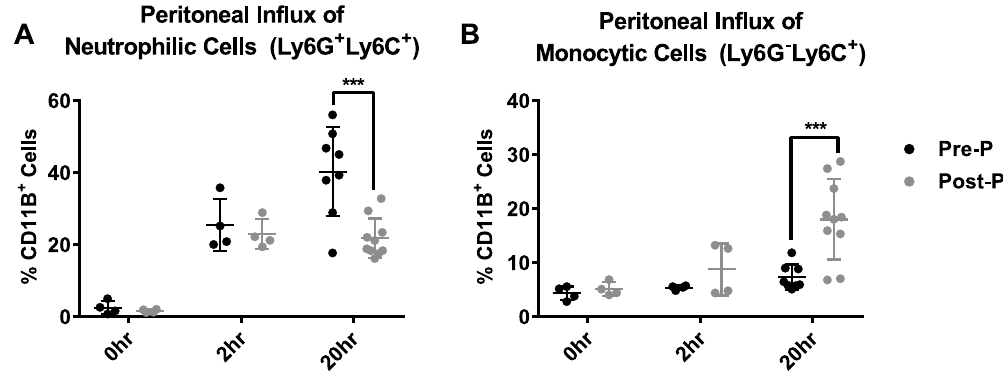
Figure 4. Pre- and post-pubertal mice show differential recruitment of monocytic and neutrophilic cells into the peritoneal cavity. At 2 and 20 hours following endotoxemia, peritoneal cells from pre- and post- pubertal (Pre-P, Post-P) C57Bl/6 mice were collected through peritoneal lavage. Cells were blocked to prevent non-specific binding and treated with antibodies targeting the myeloid lineage marker CD11B, the neutrophilic marker Ly6G, and the monocytic marker Ly6C for subsequent immuno-phenotypic analysis by flow cytometry. (N = 4/group at 0 hr; N = 4/group at 2 hr; N = 8/group at 20 hr). Pre- and post-pubertal mice exhibited different temporal patterns in the influx of (A) neutrophilic and (B) monocytic cells. For each sample, a total of ten thousand cells were analysed using the gating strategy described in Figure S4. Significant differences in concentration between pre- and post-pubertal mice are labelled with *** (p < 0.001). All comparisons were made using Two-way ANOVA followed by Tukey’s multiple comparisons